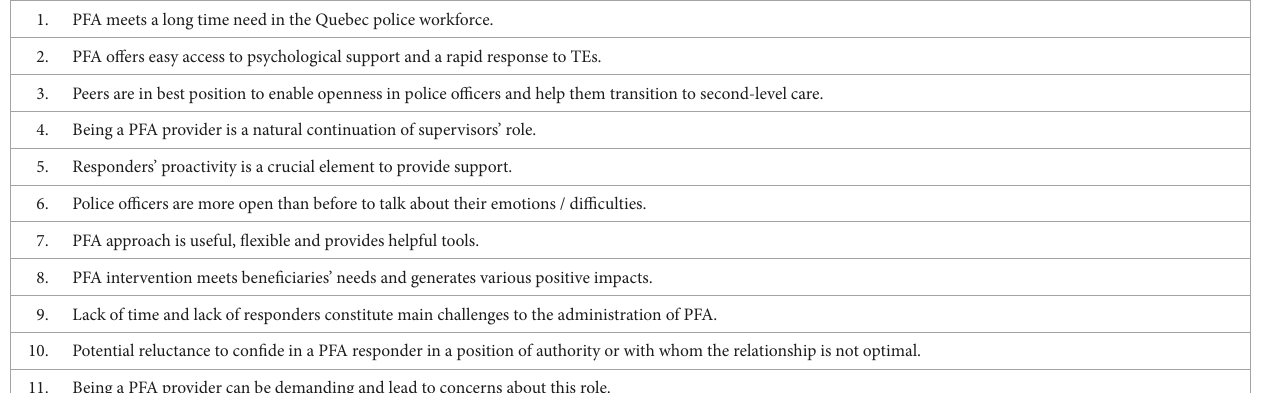
TABLE 1 Emerging themes from semi-structured